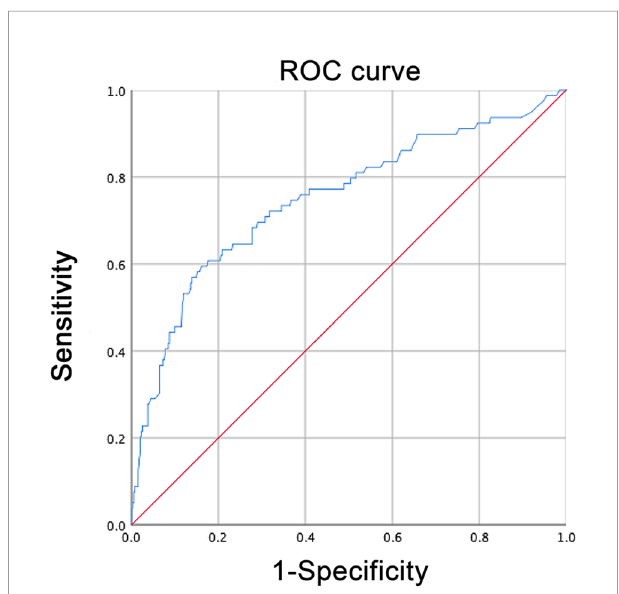
FIGURE 2 | ROC curve of the logistic regression model for predicting LN-prRLN metastasis.